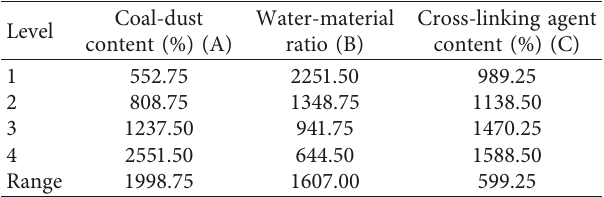
Table 4: Range analysis of the influencing factors of viscosity.